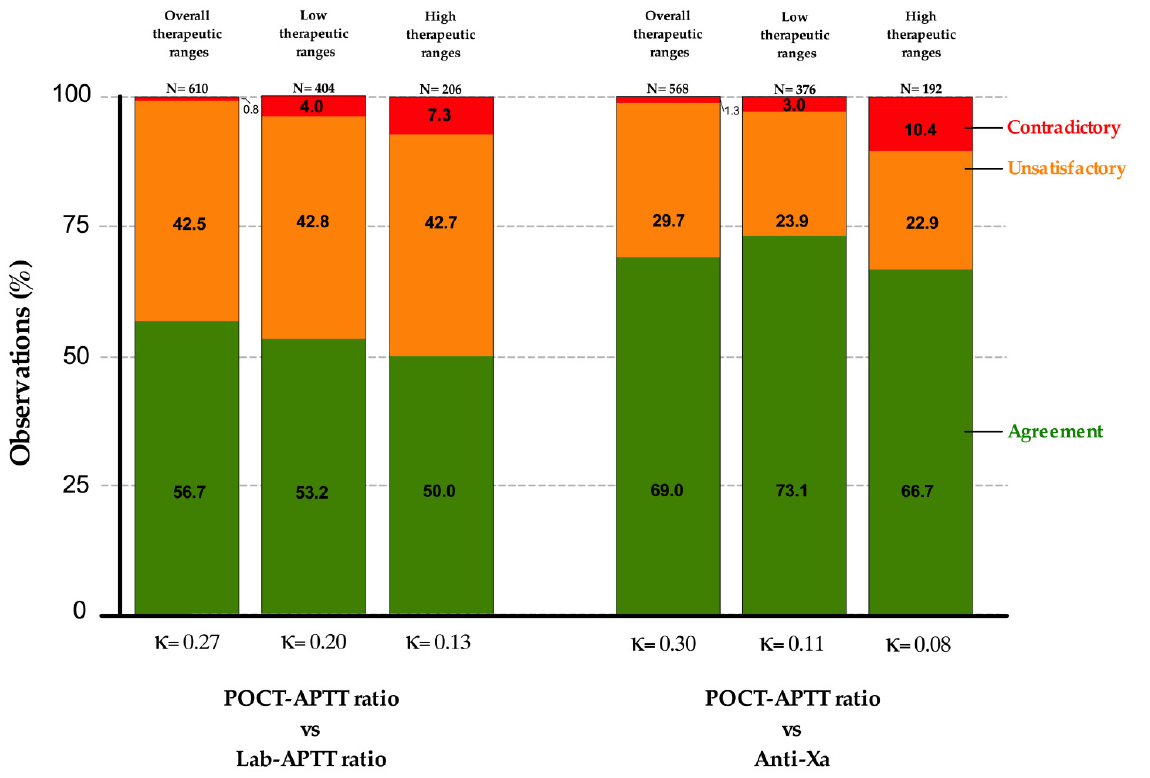
Figure 5. Relationships and inter-method agreements for POCT-APTT ratios vs. laboratory APTT ratios (left histograms) and POCT-APTT ratios vs. anti-Xa (right histograms), according to overall, low or high therapeutic ranges. Cohen’s Kappa coefficients are shown below each corresponding histogram.